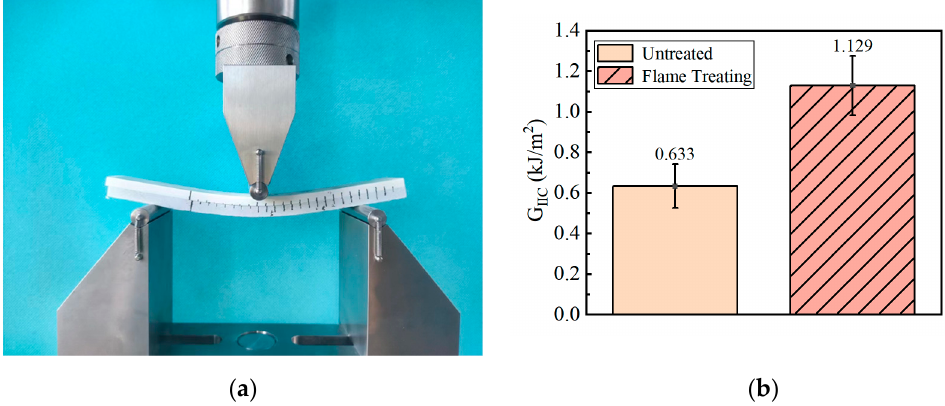
Figure 12. G Ⅱ C measurement of the ENF test: ( a ) photos of the experimental process; ( b ) experimental results.